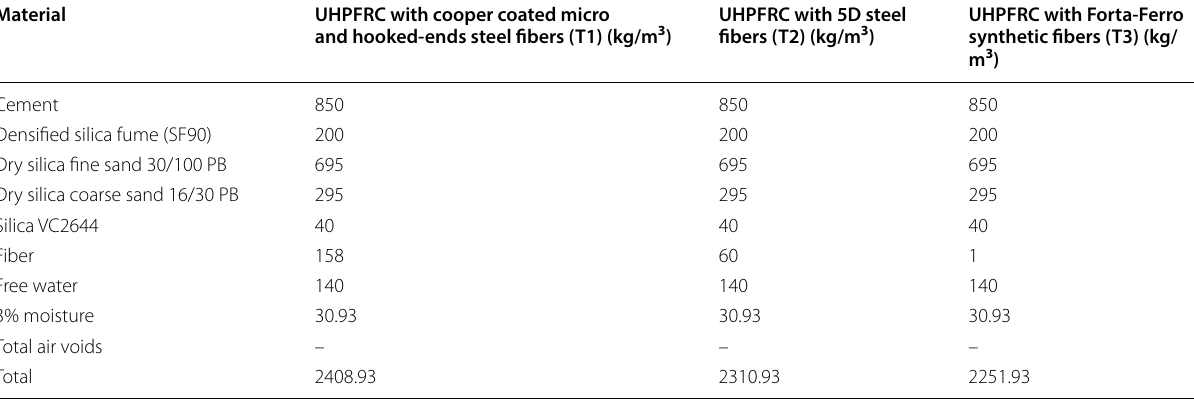
Table 1 Mix designs for UHPFRC with different fiber types